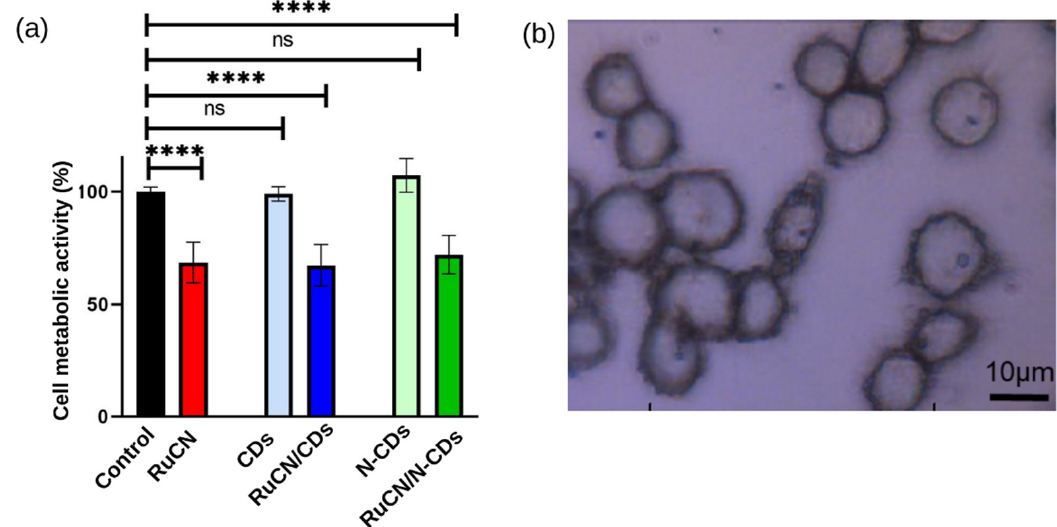
Figure 1. ( a ) Cell metabolic activity after the indicated treatments is expressed as a percentage of the nontreated cells (control) (the mean ± SD). Statistical significance was determined using the ANOVA test. ns, not significant, p > 0.05; ****, significant, p < 0.0001. ( b ) A microscopic image shows the orig- inal morphology of treated A2780 cancer cells. The microscopic images of control and cells with all treatment conditions are presented in Figure S2.